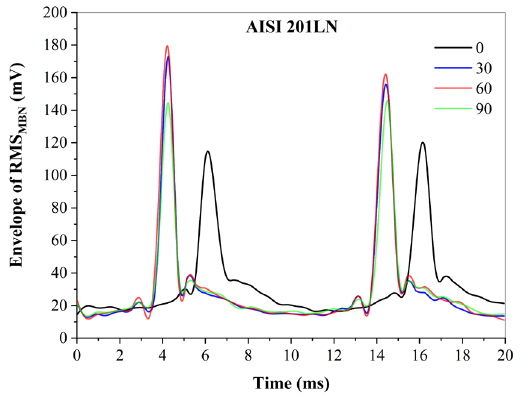
vs. time for 201LN steel. MBN